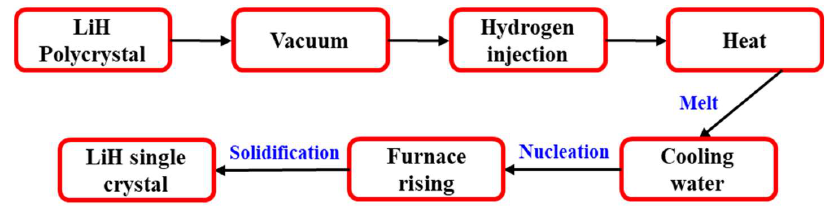
Figure 2. Lithium hydride single crystal growth process.